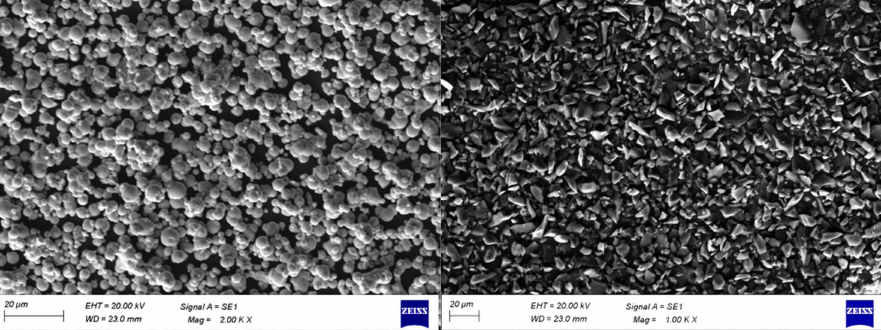
Figure 3. SEM images of CIPs ( left ) and boron carbide abrasive particles ( right